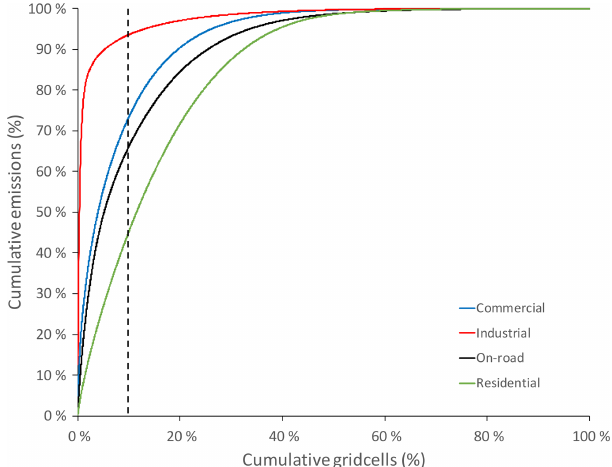
Figure 12. Cumulative FFCO 2 emissions according to key sectors in the Hestia-LA FFCO 2 emissions data product. The dashed line at 10% cumulative grid cells is given for reference. See text for